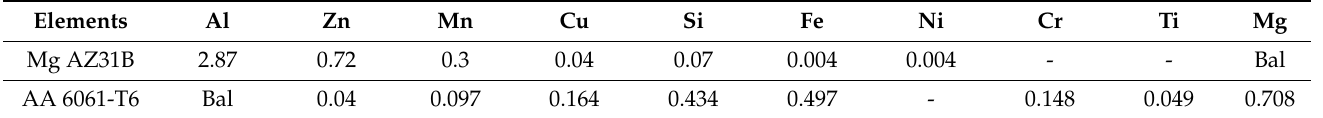
Table 1. Chemical composition of the magnesium alloy AZ31B and aluminum alloy 6061-T6 (in wt.%). Elements